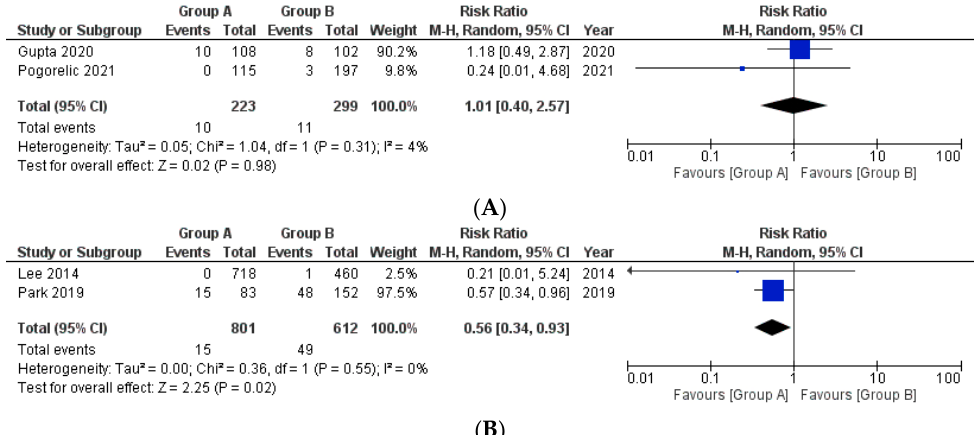
Figure 3. Forest plot comparison between the two patient groups (group A included cases where energy device was used while group B included patients in whom suture or Endoclip or Hem-o- lok ® was used) in terms of the occurrence of postoperative ileus. Figure 3A, B depict the outcome comparison with respect to appendicular base ligation and mesoappendix division respectively.